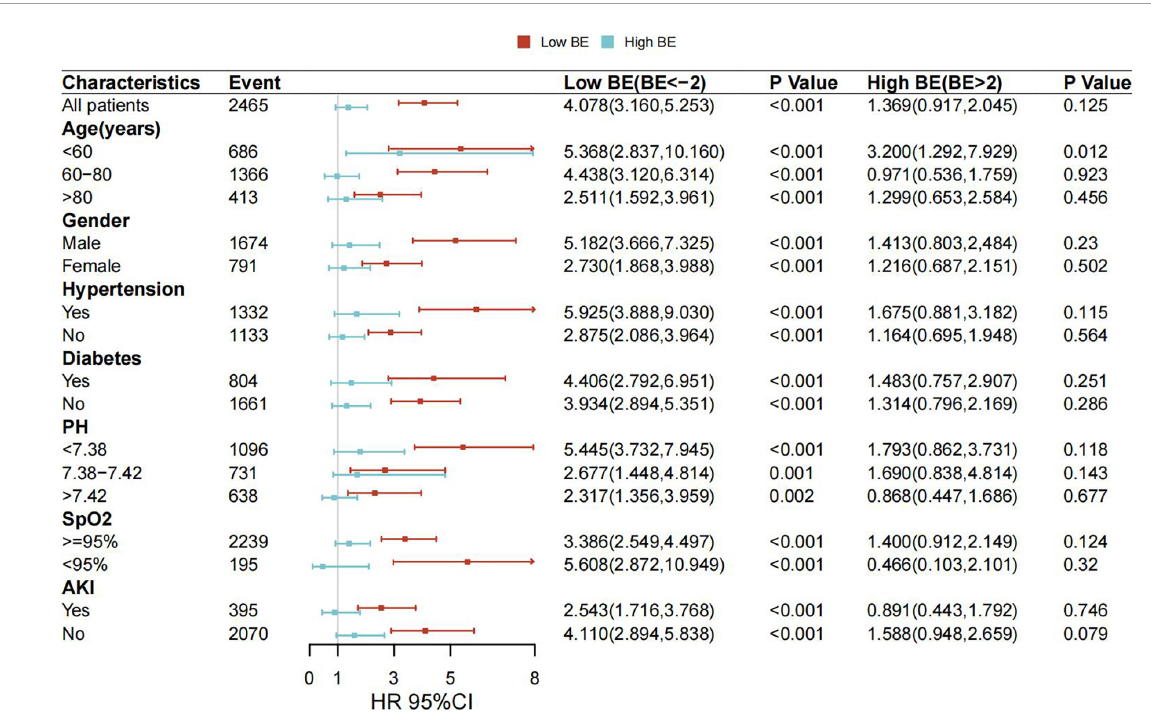
FIGURE3 Associations between BE and risk of all-cause mortality in subgroups. Forest plot and adjusted HRs with 95% CI for 28-day all-cause